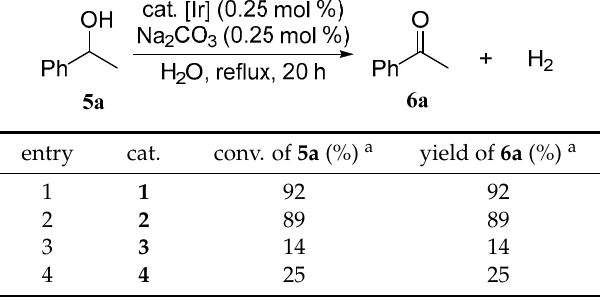
Table 1. Dehydrogenative oxidation of 1-phenylethanol ( 5a ) to acetophenone ( 6a ) in aqueous media using water-soluble iridium complexes 1 – 4 .